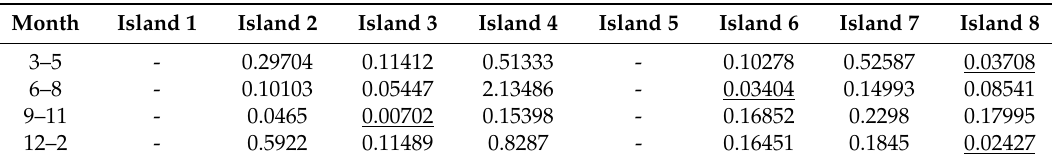
Table 2. Total squares of difference of normalized sum of power consumption by season between Island 5 (to be estimated) and remaining islands.